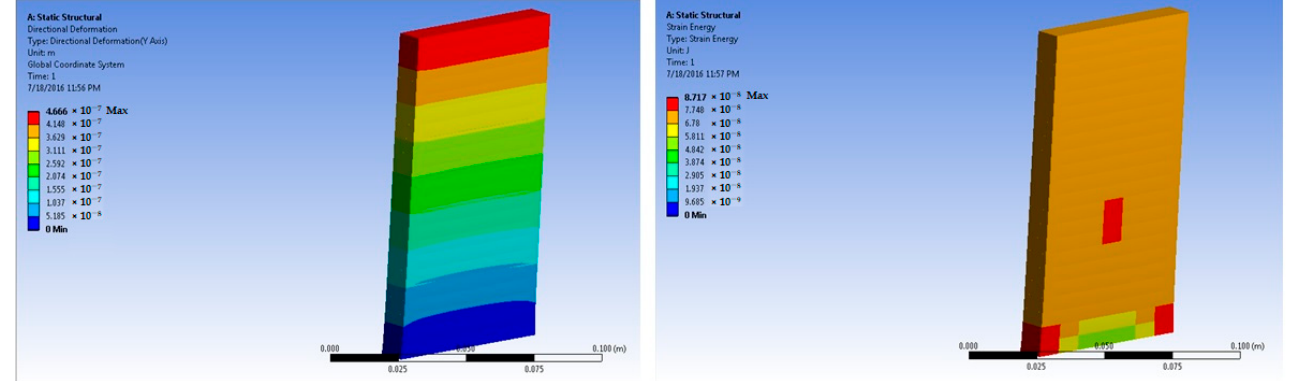
Figure 14. One percent basalt-fiber-reinforced concrete slab at 300 × 10 5 N force (deformation and strain energy).